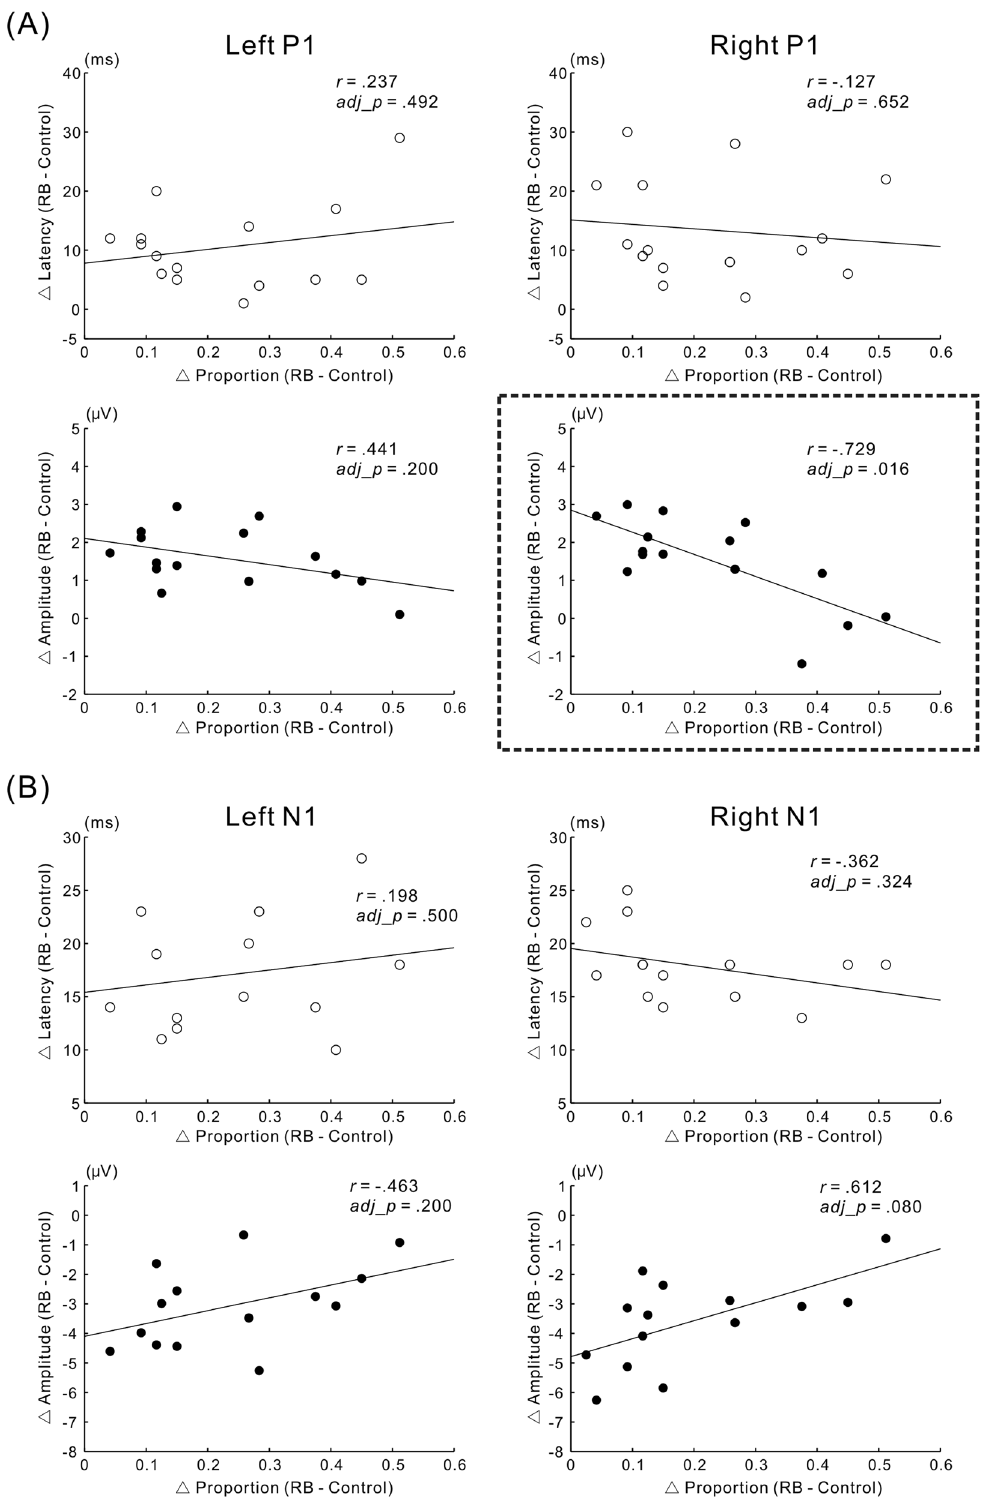
Figure 5. Relationship between VEPs and the strength of the reverse-bias effect across participants. The ordinate indicates the difference in latency or amplitude (RB–Control). The abscissa indicates the strength of the reverse-bias effect, which was quantified by subtracting the proportion of trials with the Necker lattice being perceived as an upper-left-facing lattice (opposite to the facing- orientation of the adaptor) in the Control condition from that in the RB condition. Significance was controlled by the false discovery rate (FDR: q = 0.05) throughout all correlation analyses. ( A ) The correlation between P1 and the strength of the reverse-bias effect for the left electrode ROI (left panel) and the right electrode ROI (right panel). For the right electrode ROI, there was a significant correlation between the relative enhancement of P1 in the RB condition compared with the Control condition and a decrease in the strength of the reverse-bias effect. The scatter diagram with a significant correlation is enclosed by a squared dotted line. ( B ) As for N1, there was no significant correlation between latency or amplitude and the strength of the reverse-bias effect for each electrode